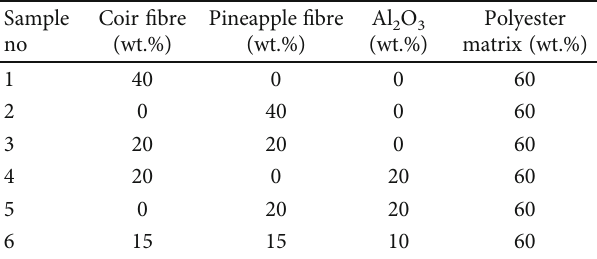
O /polyester- 2 3